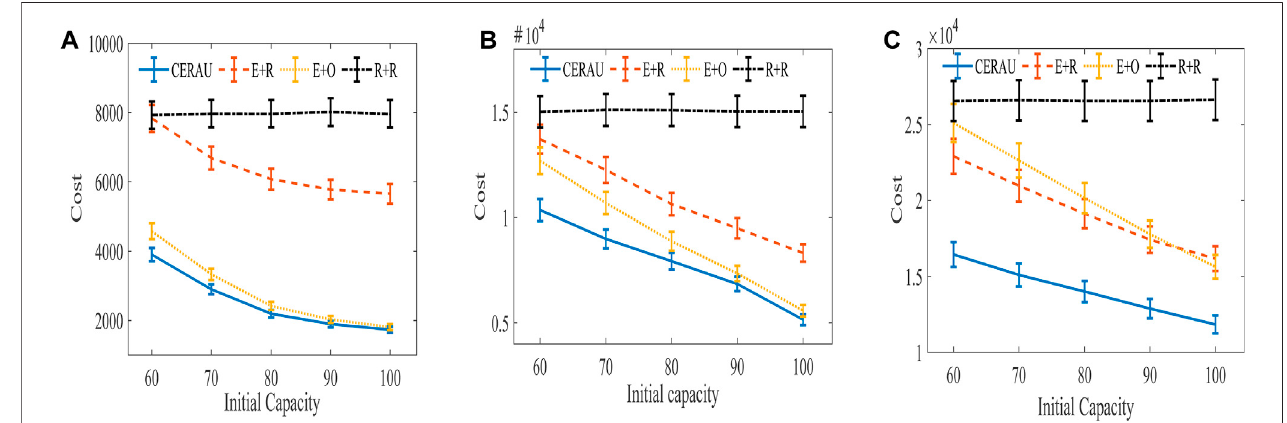
FIGURE 11 | Experimental results of the impact of demanding amount on cost with public cloud. (A) Experimental results of low intensity group. (B) Experimental results of medium intensity group. (C) Experimental results of high intensity group.